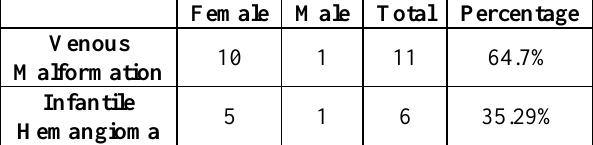
Table 2: Relation the lesion type and gender